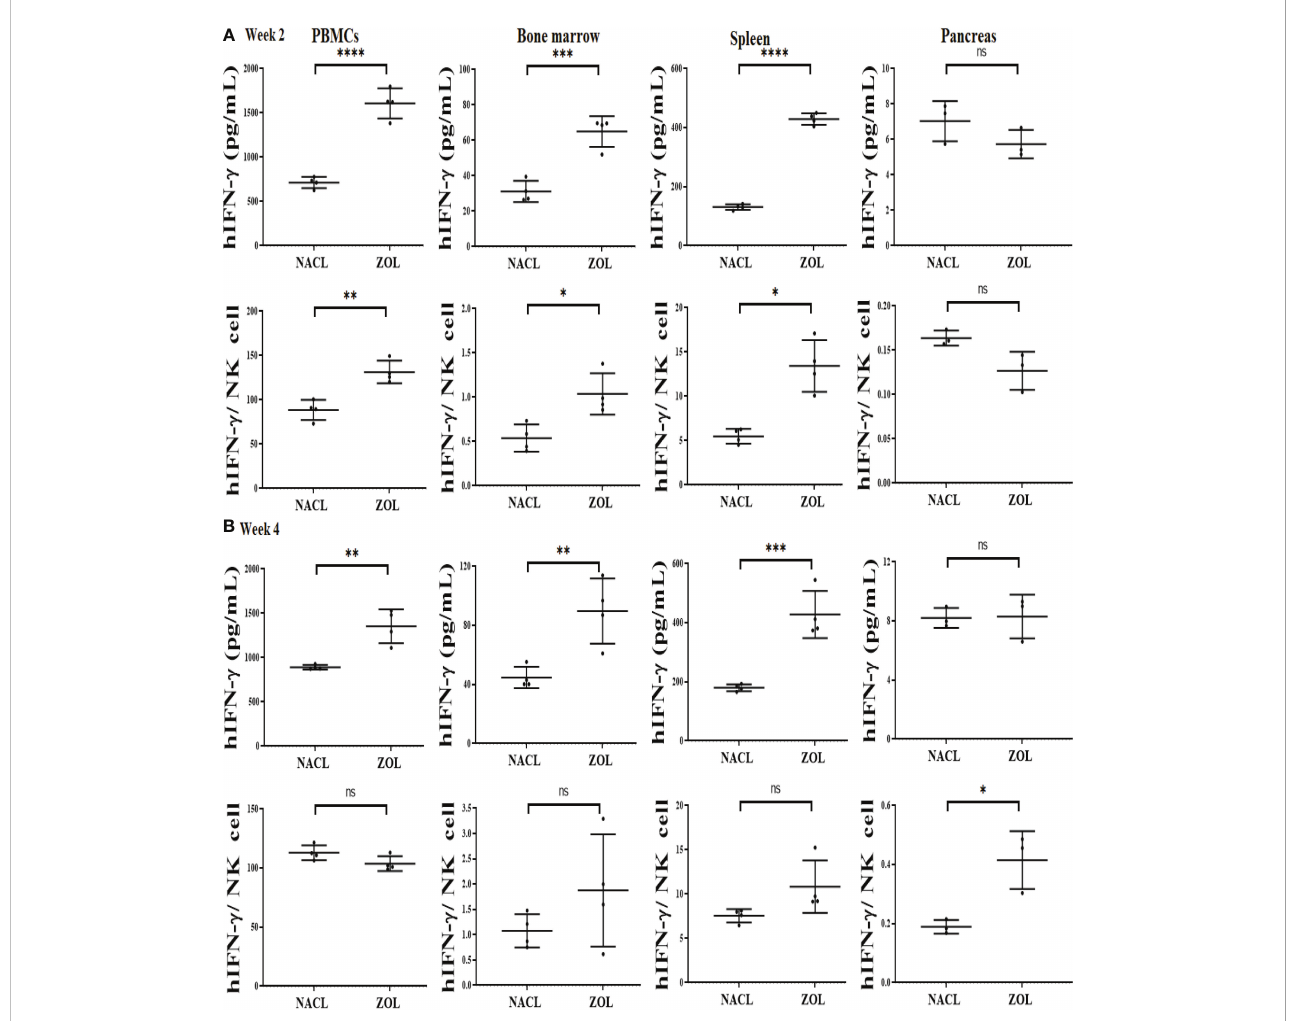
FIGURE 4 IFN- g secretion in PBMCs, BM, spleen and pancreas of NACL or ZOL-injected and tooth-extracted hu-BLT mice. Hu-BLT mice were administered with either 0.9% NACL or ZOL (500 µg/kg) via IV followed by maxillary left fi rst molar extraction as described in Materials and Methods section. Two (A) or four weeks (B) after tooth extraction, mice were euthanized and tissues were harvested to obtain single cell suspension. PBMCs (n=4), BM (n=4), splenocytes (n=4), and pancreas (n=3) of hu-BLT mice were cultured (2 × 10 6 cells/2ml) with IL-2 (1000 U/ml) for three days, after which the supernatants were harvested and the levels of IFN- g were determined using speci fi c ELISA. IFN- g secretion per human CD45+ cell was determined using CD45 percentages obtained by fl ow cytometric analysis. IFN- g per one NK cell was determined using CD16+CD56+ percentages obtained by fl ow